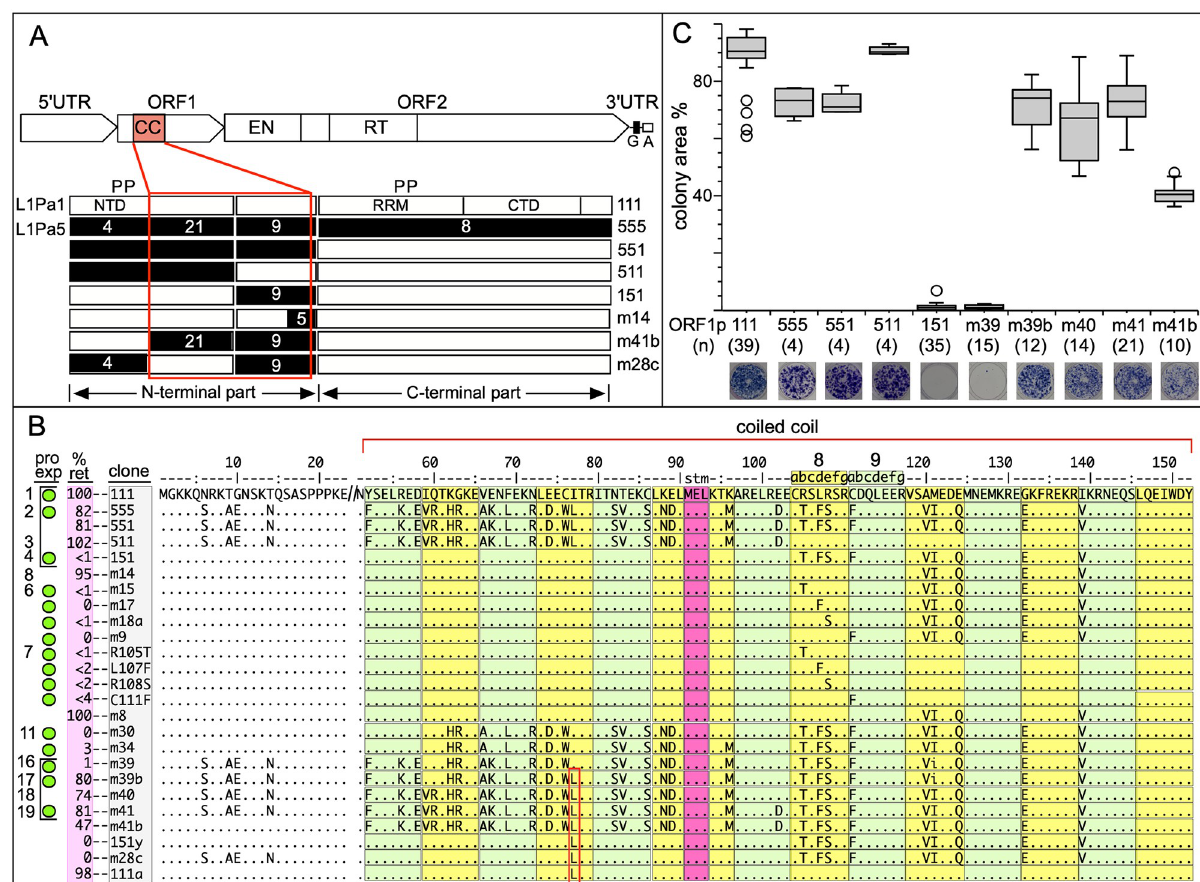
Fig 1. Retrotransposition of ORF1p variants. A —Generic L1 retrotransposon [1, 43]: 5’ UTR (untranslated regulatory region); ORF1 (open reading frame1) with coiled coil domain (CC), which mediates trimerization of ORF1p necessary for high affinity nucleic acid binding and chaperone activity [40, 44–46]; ORF2, encodes the L1 replicase with endonuclease (EN) and reverse transcriptase (RT) domains; 3’ UTR with a conserved G-tetraplex forming domain (G) [47, 48] and an A-rich tail (A). P, location of conserved phosphorylation sites in mammalian ORF1p required for retrotransposition [1, 49]. NTD, RRM, CTD, N-terminal domain, RNA recognition motif, C-terminal domain, respectively. Also depicted are schematics of 8 ORF1p sequences 7 of which are mosaic structures consisting of the indicated regions of a modern active L1Pa1 (L1Hs) ORF1p (white, 111) and a resuscitated ancestral L1Pa5 ORF1p (black, 555) [26]. The names of the variants are given on the right and the white numbers indicate their amino acid differences. B —Alignment of the N-terminal 23 amino acids and the entire 14 heptad coiled domain (alternating green and yellow boxes). Note, the heptads are numbered from 1–14 (only 8 & 9 are indicated) so as to be congruent with amino-carboxy orientation of the protein. L1Pa1 ORF1p is the reference sequence and dots and letters indicate respectively identities and differences between it and the other variants. Four columns are listed on the left: Numbers, corresponding to the subset of the variants shown in S3 Fig that were mapped on the coiled coil sequence space shown in Fig 2; pro exp—green dots, variants tested for protein expression in HeLa cells. Both active and inactive protein were expressed (S1 Fig); % ret—% retrotransposition activity in HeLa cells; clone–variant names. The a-g heptad amino acid positions are shown for heptads 8 and 9, stm indicates the stammer in heptad 6. C –Box plots of retrotransposition assays of selected variants (bracketed in panel B ) and representative stained G418 resistant foci and the numbers (n) of independent transfections (biological replicates) are indicated. Retrotransposition results of the other variants are shown in S2